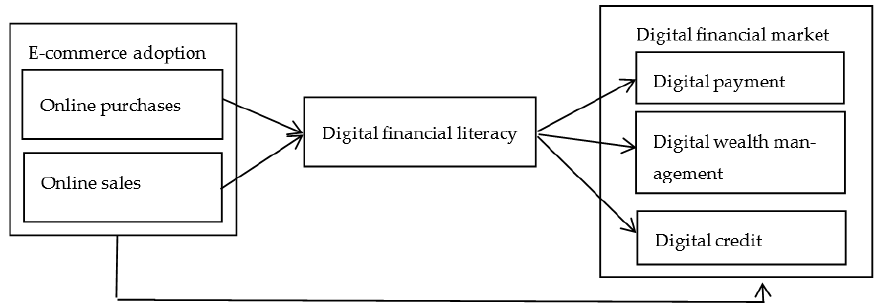
Figure 1. The conceptual framework.